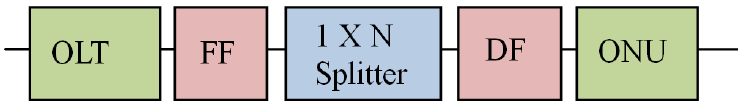
Figure 9. Reliability block diagram for unprotected EPON architecture. Table 4. Reliability data [22].